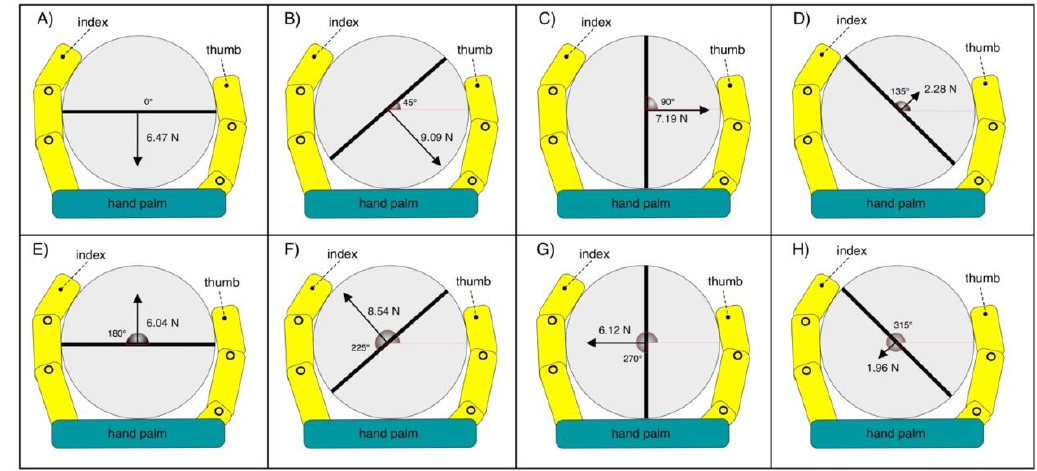
Figure 15. Measured force represented as vectors, for each tilt of the handlebar: ( A ) 0 degrees; ( B ) 45 degrees; ( C ) 90 degrees; ( D ) 135 degrees; ( E ) 180 degrees; ( F ) 225 degrees; ( G ) 270 degrees; ( H ) 315 degrees.